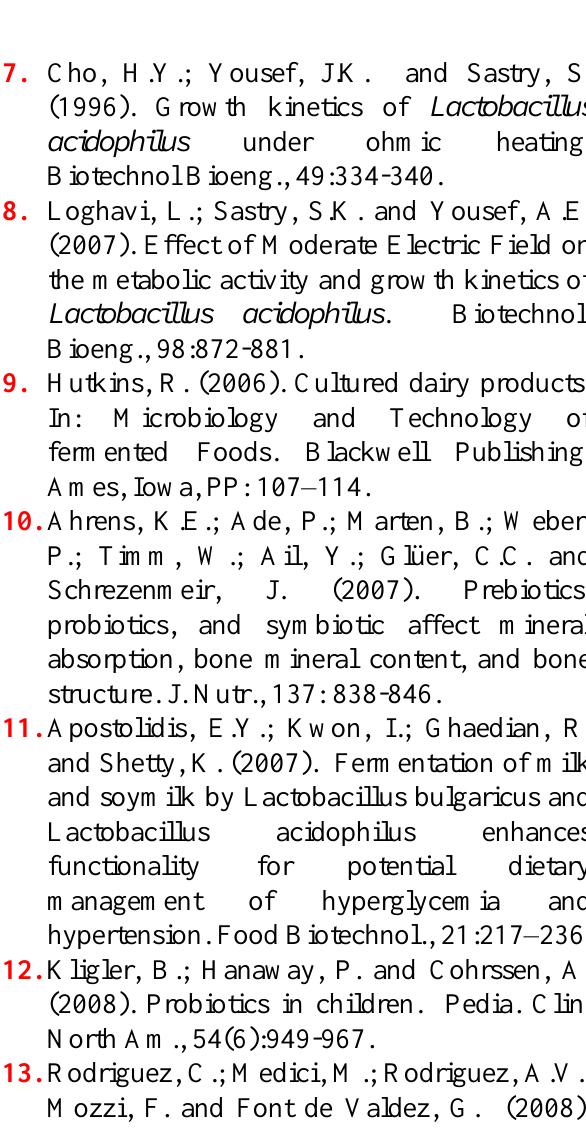
Figure, 4: The influence of mild pulsed electric field conditions on the protease activity of Lactobacillus acidophilus